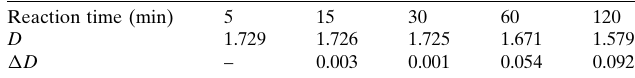
Table 1 Fractal dimension index ( D ) of Ag-DNF/Si substrates synthesized for various times.